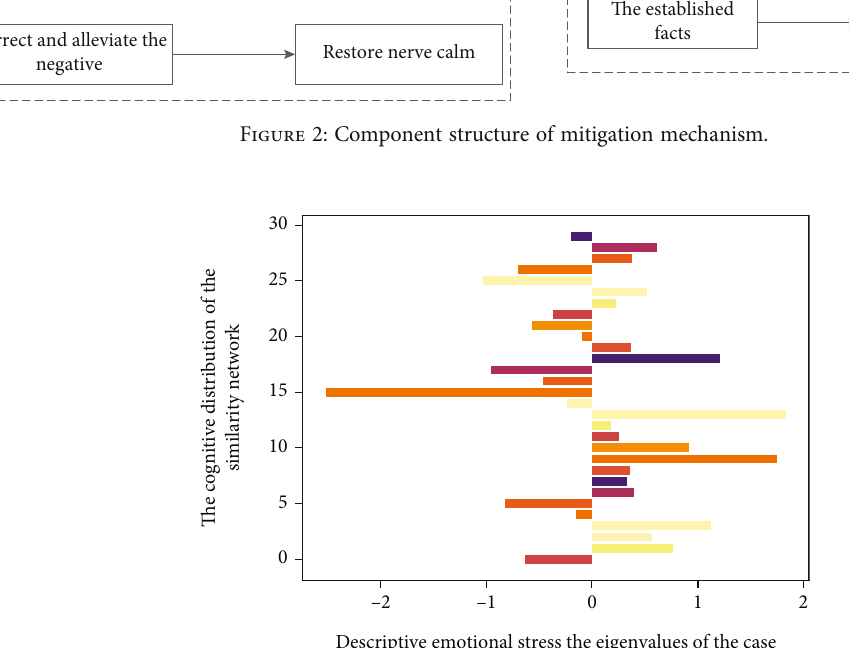
Figure 3: Descriptive cognitive distribution of emotional